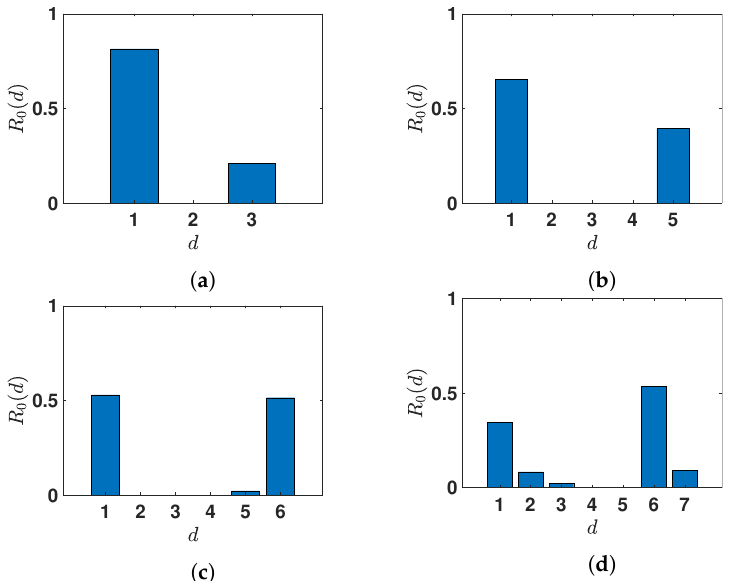
Figure 10. We plot the daily basic reproduction numbers R 0 ( d ) obtained for n = 3 in ( a ), n = 5 in ( b ), n = 6 in ( c ), and n = 7 in ( d ). The distribution for n = 7 corresponds to the red curve in Figure 9.